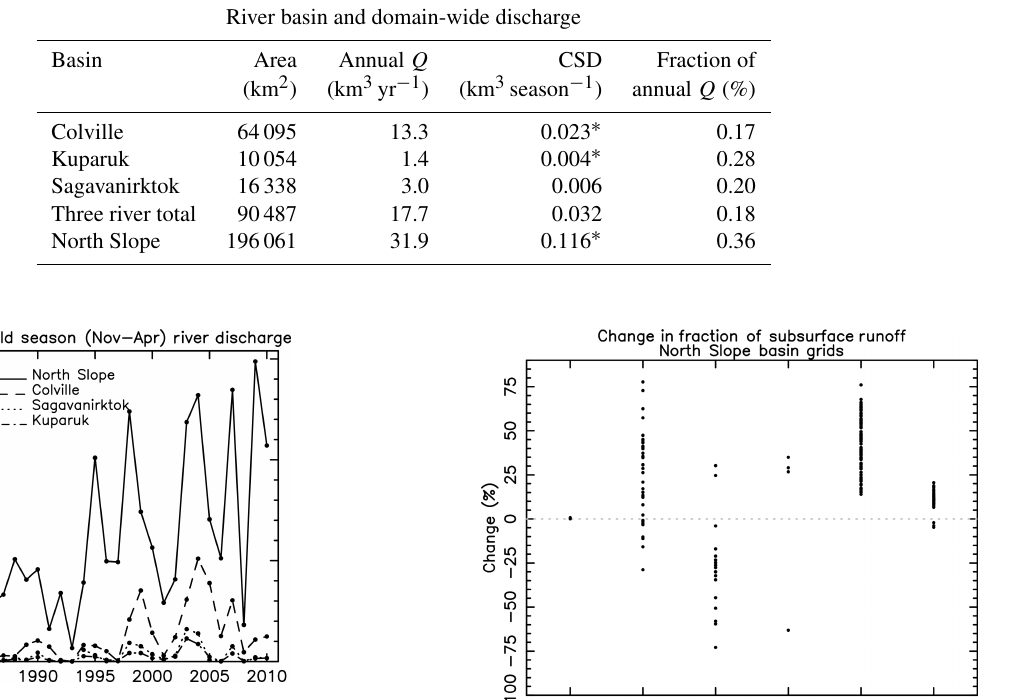
Figure 6. Simulated cold season (November–April) Q (CSD, km 3 season − 1 ) for the full North Slope region and for the Colville, Sagavanirktok, and Kuparuk rivers. Most CSD occurs in November and December.